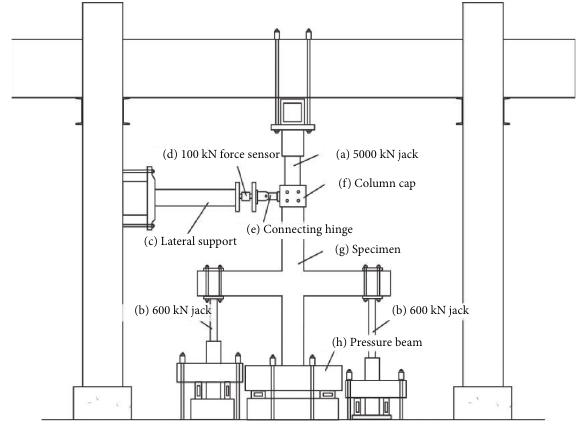
Figure 6: The schematic of loading